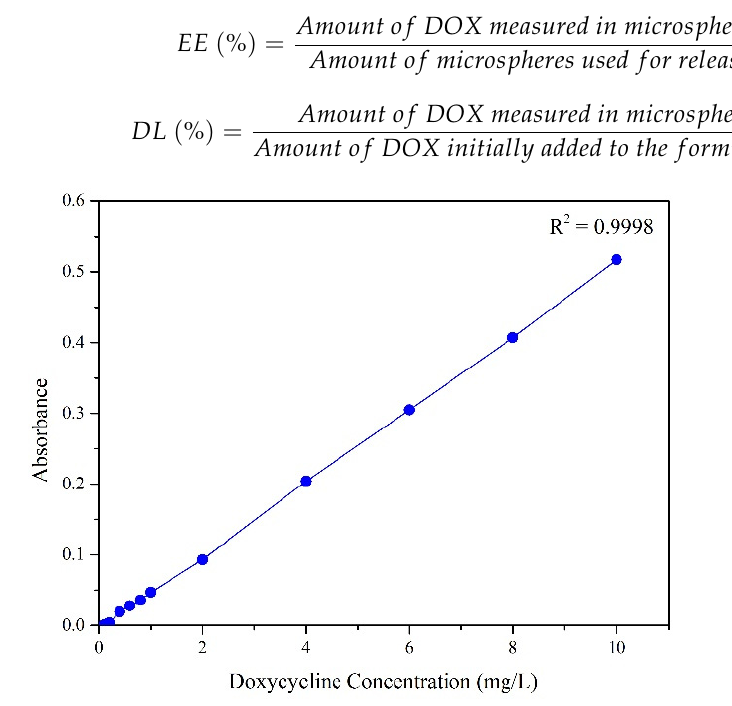
Figure 1. Standard curve obtained from known concentrations of DOX analyzed by UV–VIS spec- trophotometry.